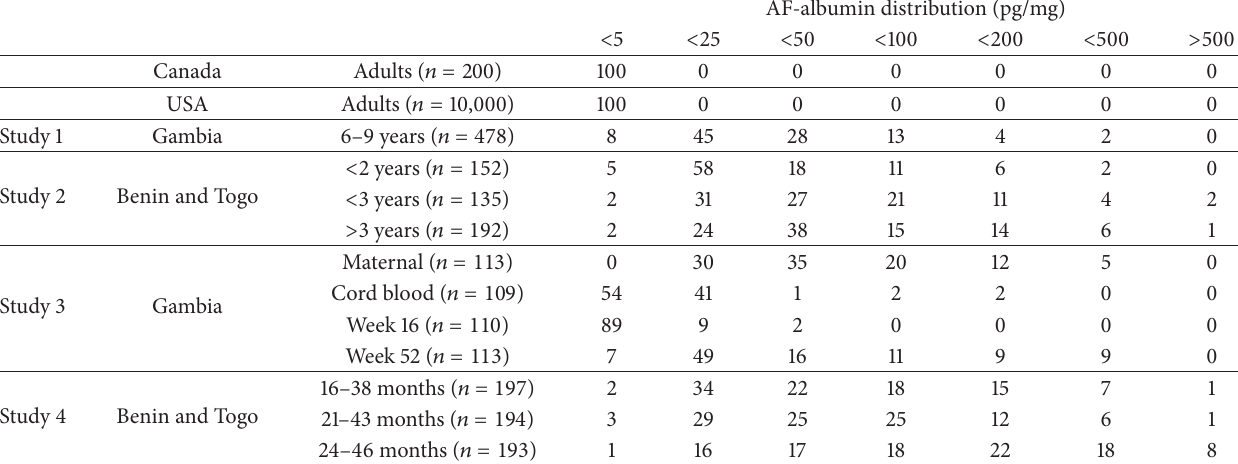
Table 1: AF-albumin adducts concentration distribution from studies 1–4 on assessing growth and data from Canada and the USA. Data presented are the percentage within each study within one of the pg/mg concentration groups (modified from [21, 22, 95, 98]: [102–104];